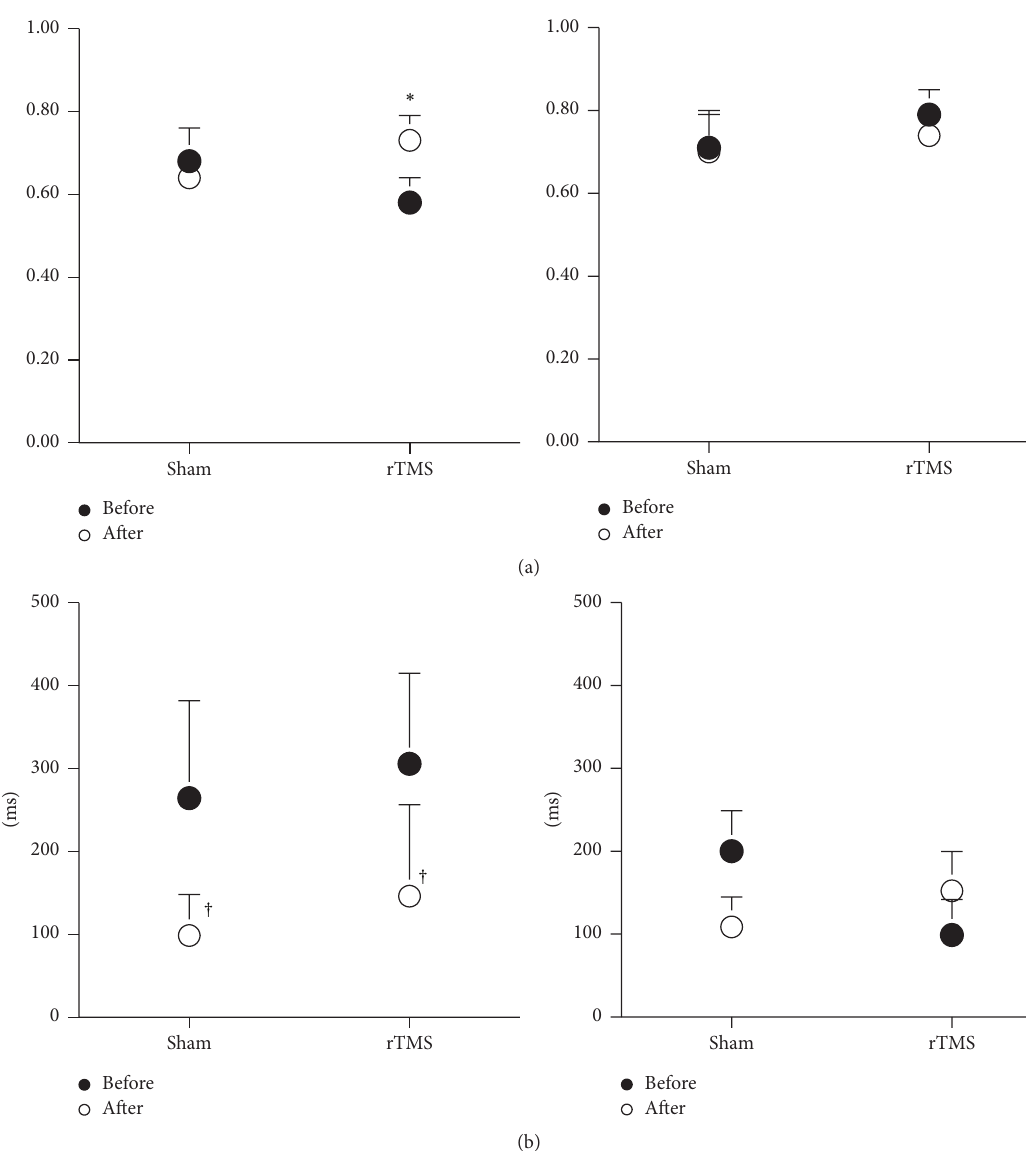
Figure 6: Reach-to-grasp coordination for the small object (left) and the large object (right) pre ( e ) and post ( I ) each TMS condition. (a) Highest cross-correlation coefficient. (b) Associated time lag. ∗ indicates a significant interaction between the TMS condition and time. † indicates a significant difference before compared to after TMS